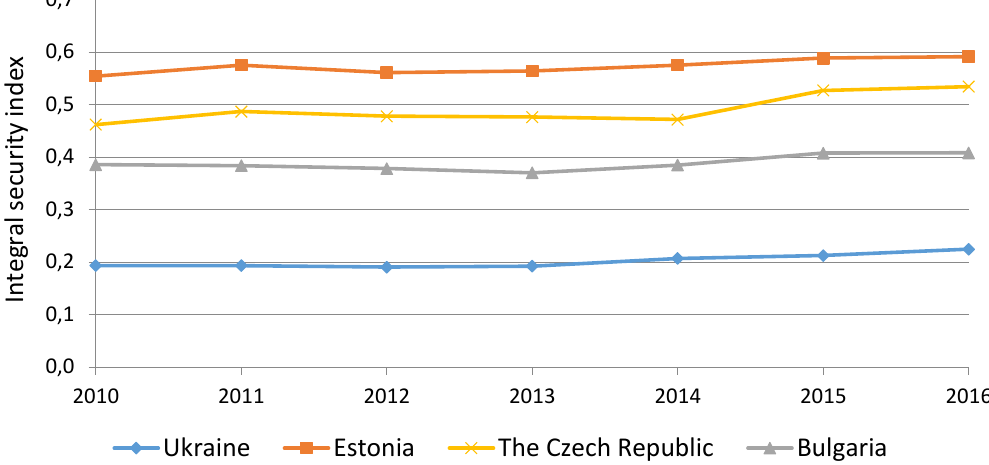
Figure 1. Dynamic of the integral index of business environment security in Ukraine and the countries-leaders of the groups